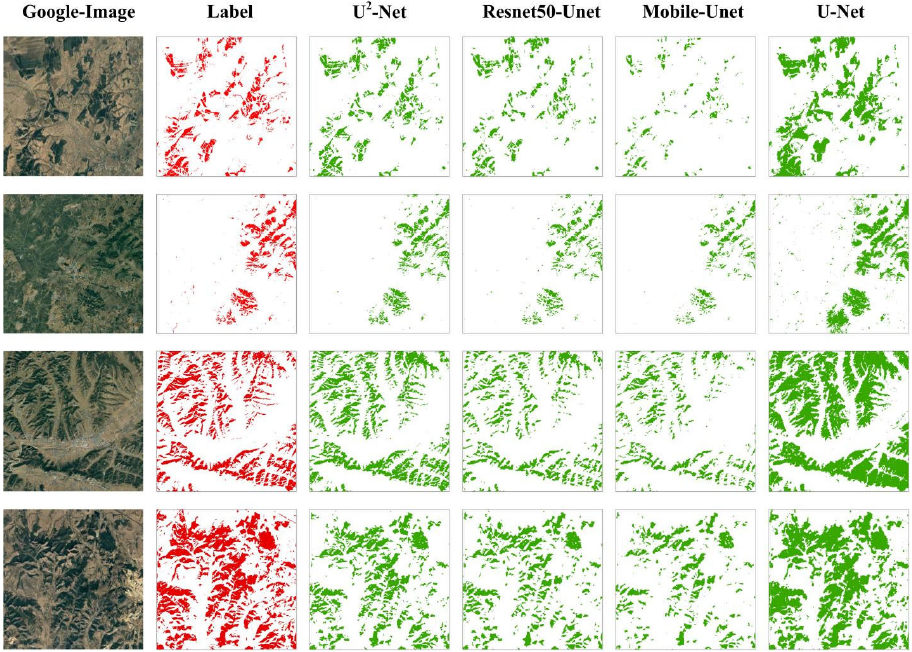
Figure 12. The extraction results of the coniferous forests with different densities using deep learning models.